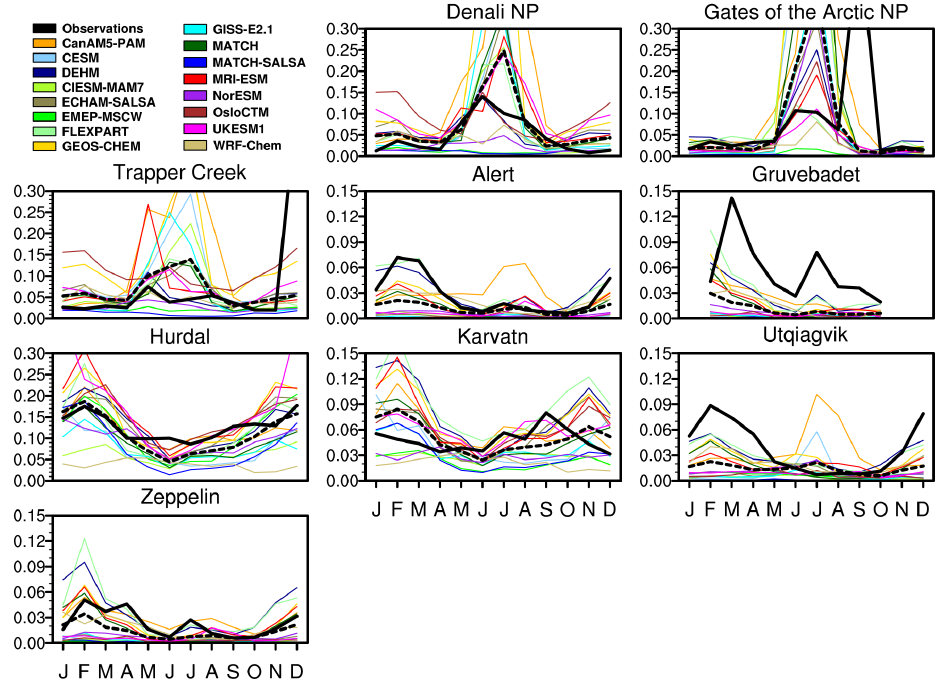
Figure 15. Modeled (thin colored lines) and measured (thick black line) monthly mean BC concentrations (in µgm − 3 ) at surface Arctic measurement sites in 2014–2015. The multi-model mean is shown by the black dashed